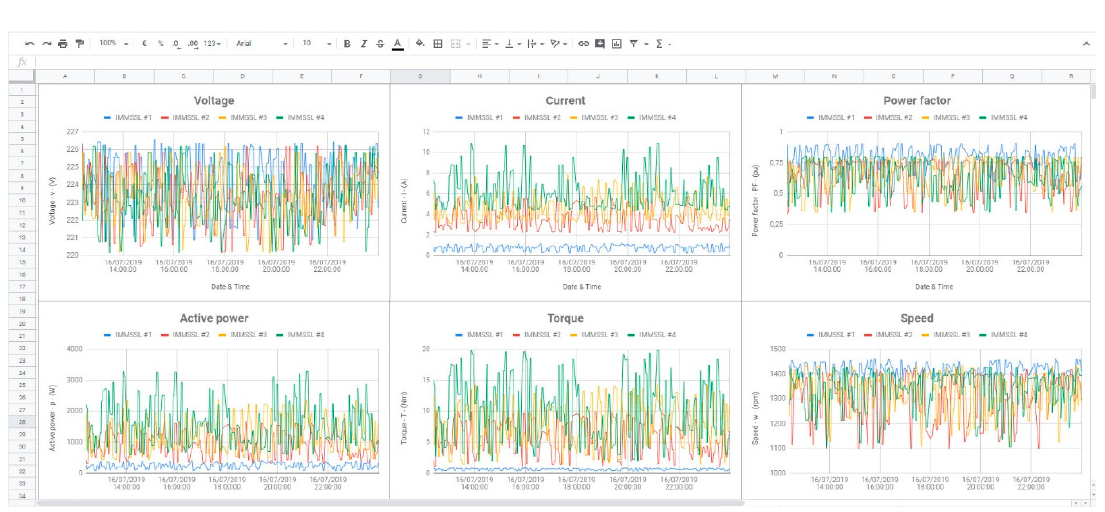
Figure 16. Graphs of electrical and mechanical variables in Google Sheet.